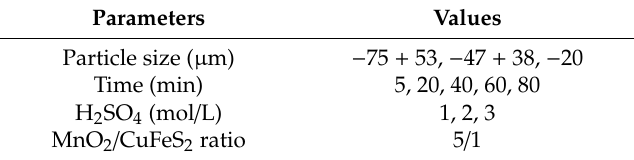
Table 5. Experimental conditions for the study of the e ff ect of chalcopyrite particle